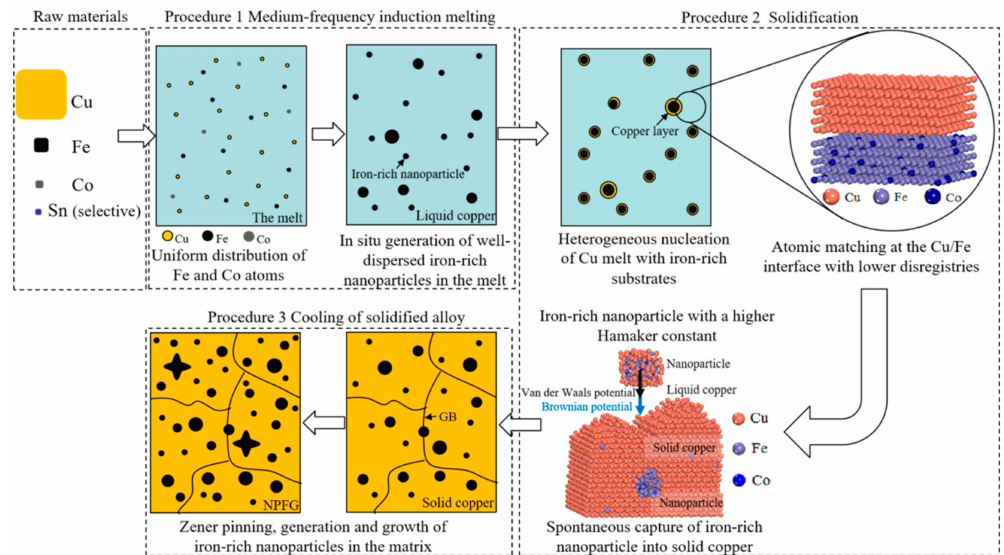
Figure 2. Schematic of microstructural evolution during casting process that produced NPFG structure